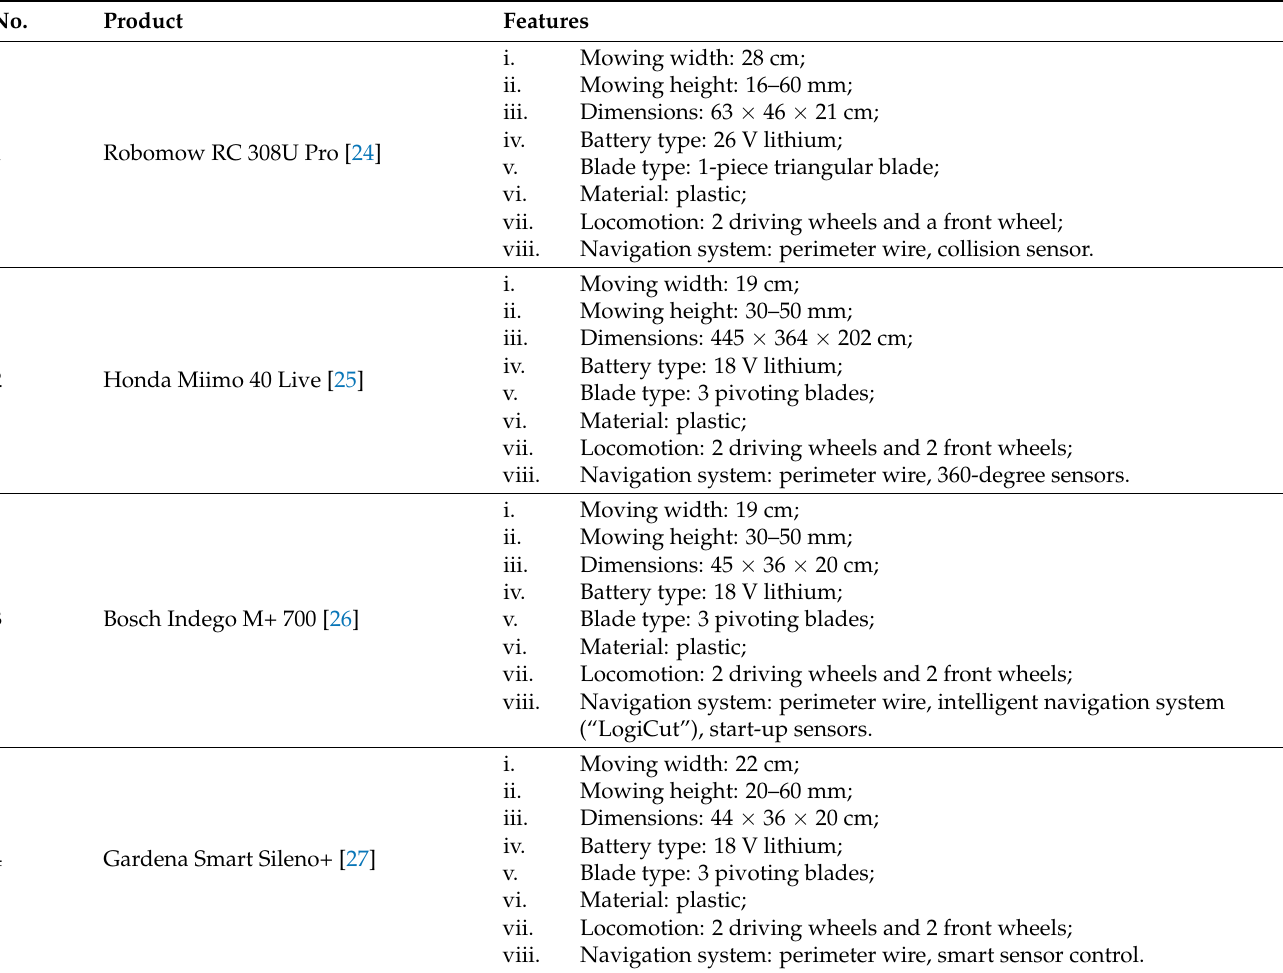
Table 17. Comparison of the basic features of existing robotic